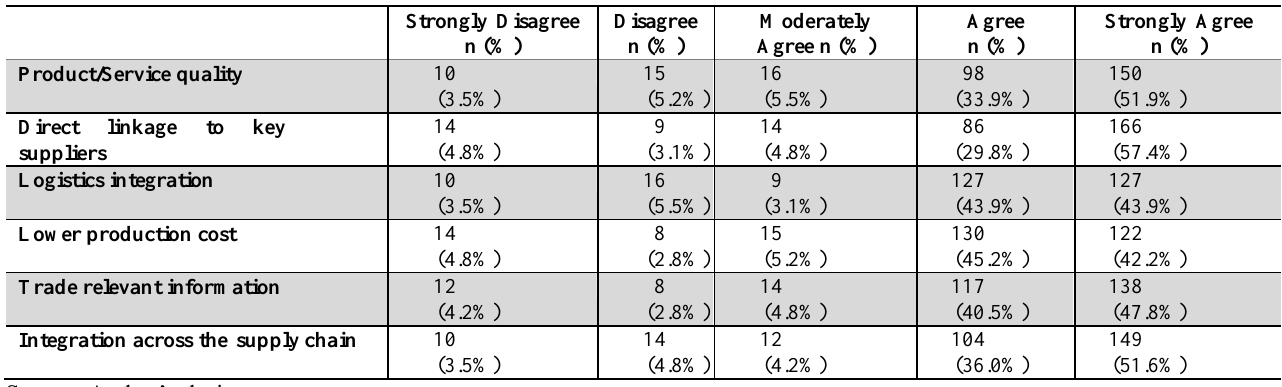
Table 2: The extent to which information technology adoption can improve - supply chain integration Strongly